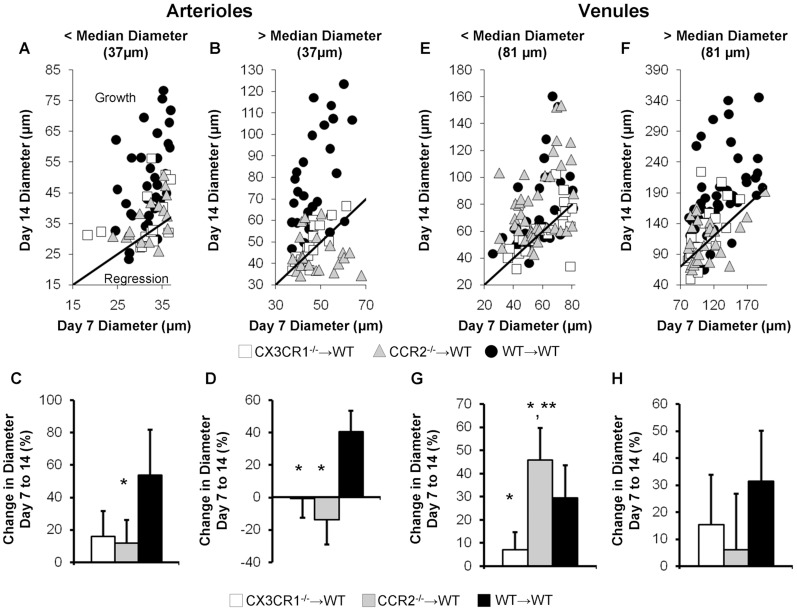
Influence of initial vessel diameter on remodeling.Arteriole (A–D) and venule (E–H) remodeling data were split into initial day 7 diameters above and below median diameter. Illustration of growth and regression for CX3CR1−/−→WT, CCR2−/−→WT, and WT→WT mice (A, B, E, F). Quantification of percent change in maximally vasodilated diameter of arteriole (C, D) and venule (G, H) segments from day 7 to day 14. [*, ** indicate p<0.05 significant differences versus WT→WT and CX3R1−/−→WT, respectively, n = 4–7 mice per group].